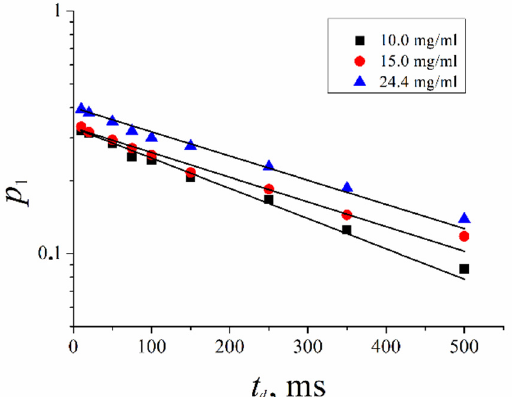
Figure 9. Dependences of associate molecules populations of compound XI on diffusion times. The values of concentrations are indicated in